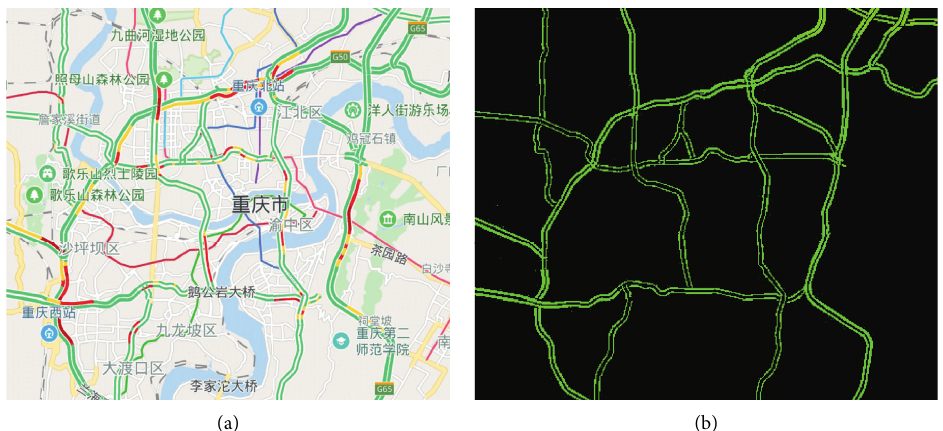
Figure 1: Sample of our input data. (a) the raw screenshot of Baidu Maps. (b) the filtered traffic condition map based on the citywide traffic network.